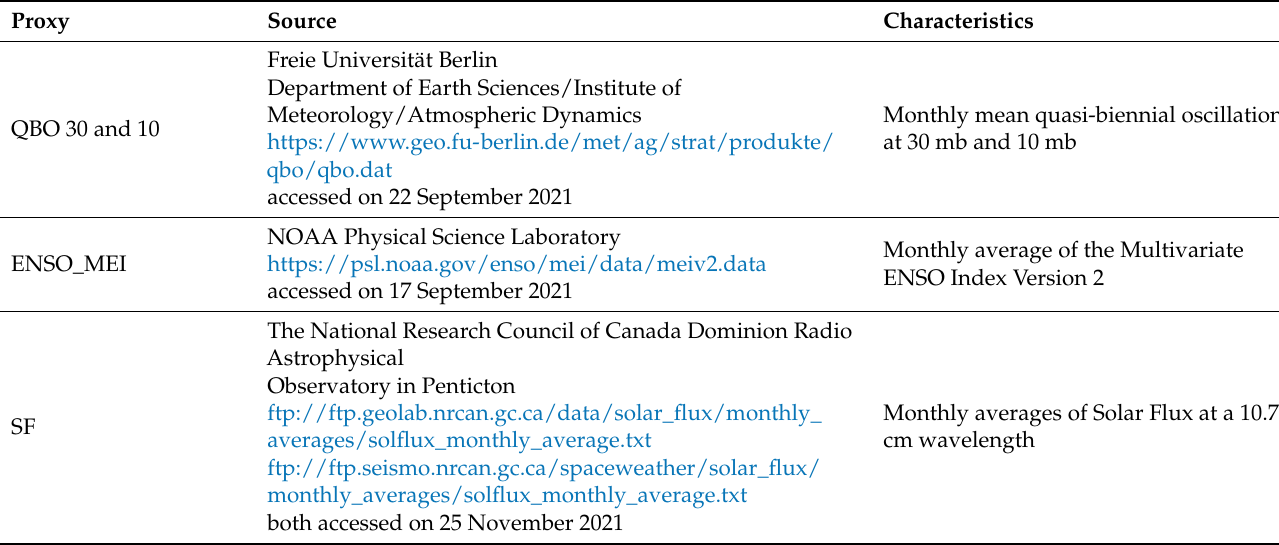
Table 1. Proxies used in this paper are present in column 1 and the corresponding sources and characteristics are in columns 2 and 3, respectively.